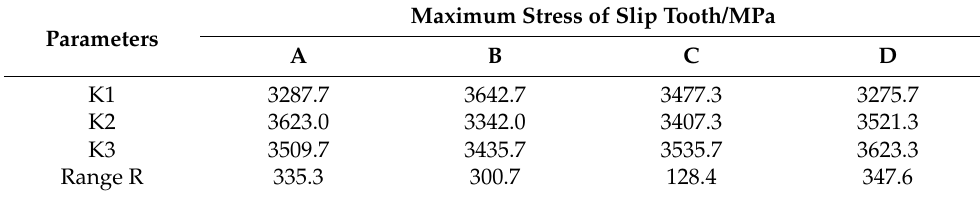
Table 5. Range analysis of maximum stress of slip tooth.